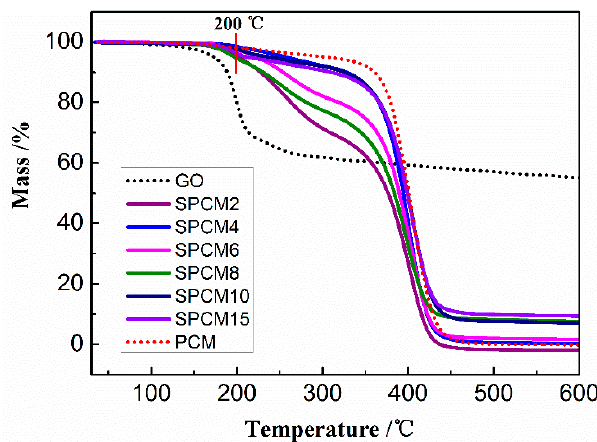
Figure 9. Thermogravimetric (TG) analysis curves of GO, P(TDA- co -HDA), and the